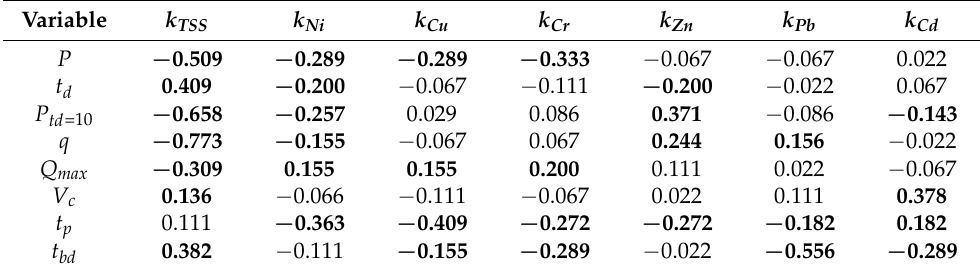
Table 4. The matrix of correlation between the analyzed parameters.